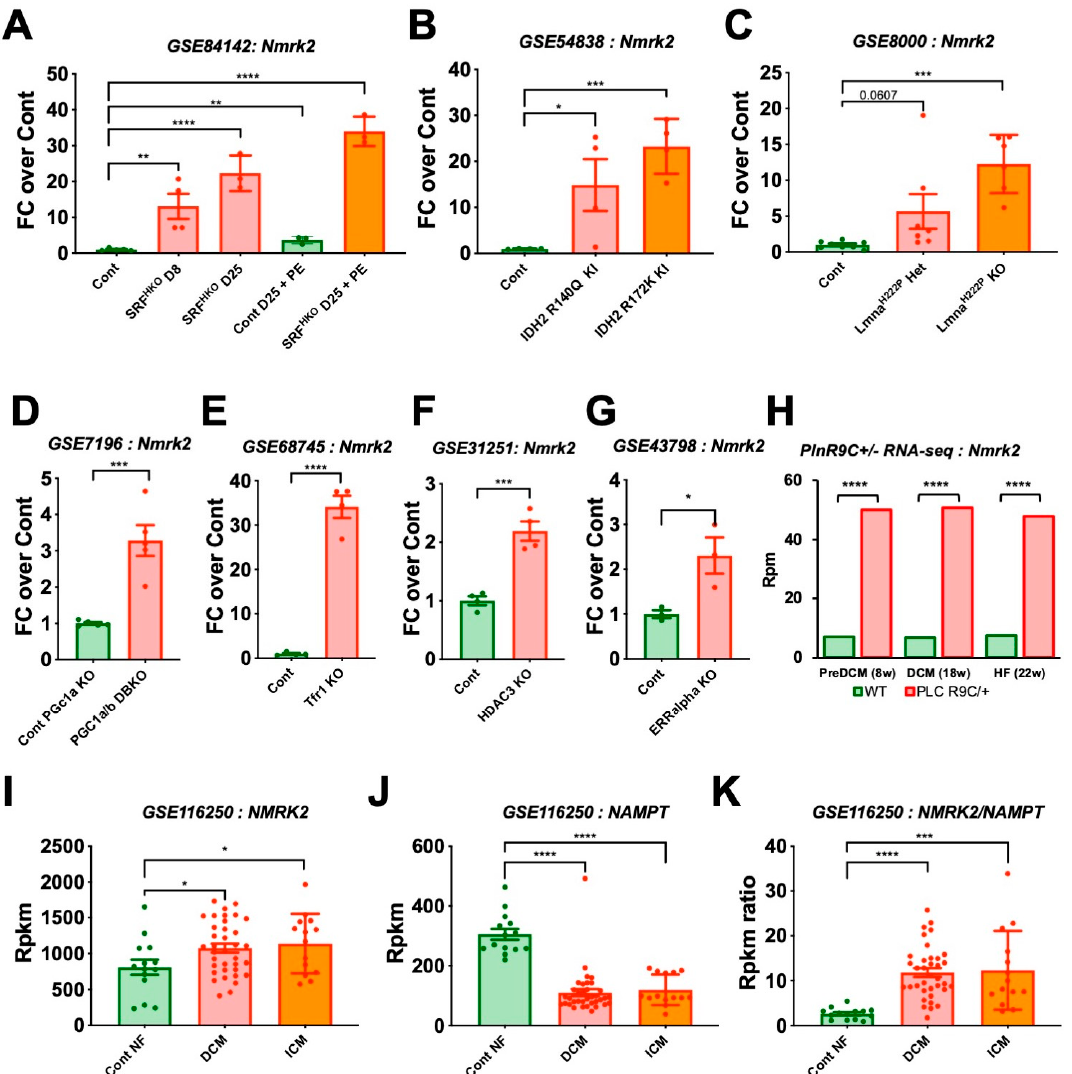
Figure 1. Nmrk2 is upregulated in different models of dilated Cardiomyopathy (DCM). Public Table 4. month-old adult mice analyzed at day ( D ) 8 and D25 after cardiac-specific deletion of the Serum Response Factor gene (SRF HKO mutant), or D25 with phenylephrine administration (80 mg/kg/day, 15 days), and controls ( n = 3 to 5 mice/group) [9]. ( B ) Adult mice analyzed at 1 month after conditionally-activated expression of isocitrate dehydrogenase 2 mutants (IDH2) R140Q and R172K ( n = 4 mice/group) [22]. ( C ) A-type lamin Lmna H222P homo-/heterozygous mutants at 10 weeks of age, an early pre-symptomatic stage ( n = 6 to 8 mice/group) [23]. ( D ) 2 to 3-month-old adult mice doubly deficient for peroxisome proliferator-activated receptor γ coactivators Pgc-1 α (global KO) and Pgc-1 β (cardiac-specific KO, 1 month after deletion) versus Pgc-1 α KO ( n = 4 mice per group) [25]. ( E ) 10-days-old pups with cardiac-specific deletion of the transferrin receptor 1 gene ( Tfr1 ) ( n = 4 mice/group) [26]. ( F ) 6-week-old mutants deleted for histone deacetylase 3 (HDAC3). Deletion occurred 7 days after birth ( n = 4 mice/group) [27]. ( G ) 2 to 3-month-old adult mice lacking estrogen-related receptor alpha (ERRalpha) ( n = 3 mice/group) [28]. ( H ) Adult mice expressing a missense mutation (p.Arg9Cys) in phospholamban (PLNR9C/+) analyzed at early asymptomatic pre-DCM stage (8 weeks), DCM stage (18 weeks) and HF stage (22 weeks). RNA was extracted from purified cardiomyocytes, pool of 3 mice/group, p values are indicated as from supplementary table in reference [7]. ( I–K ) RNA-seq data from human patients, non-failing (NF, n = 14) controls, DCM ( n = 37) and ischemic cardiomyopathy (ICM, n = 13) [31]. ( I ) NMRK2 and ( J ) Nicotinamide phosphoribosyl transferase ( NAMPT) expression level; ( K ) NMRK2 on NAMPT expression ratio. Dots are values for each individual in A to I. Data are shown as mean fold change over mean control value (colored bars) +/- SEM (error bars) in I to K. GEO dataset reference is indicated in each panel. Statistics: Only comparison of each mutant group against the control groups were planned. t-test: *, p ≤ 0.05; **, p ≤ 0.01 ***; p ≤ 0.001; ****; p ≤